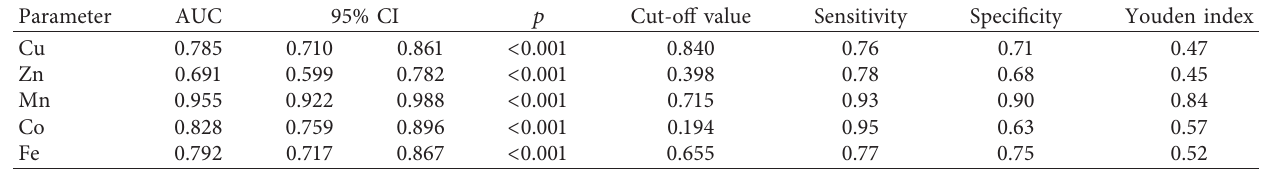
Table 2: AUC, cut-off value, sensitivity, and specificity for the analyzed heavy metals.